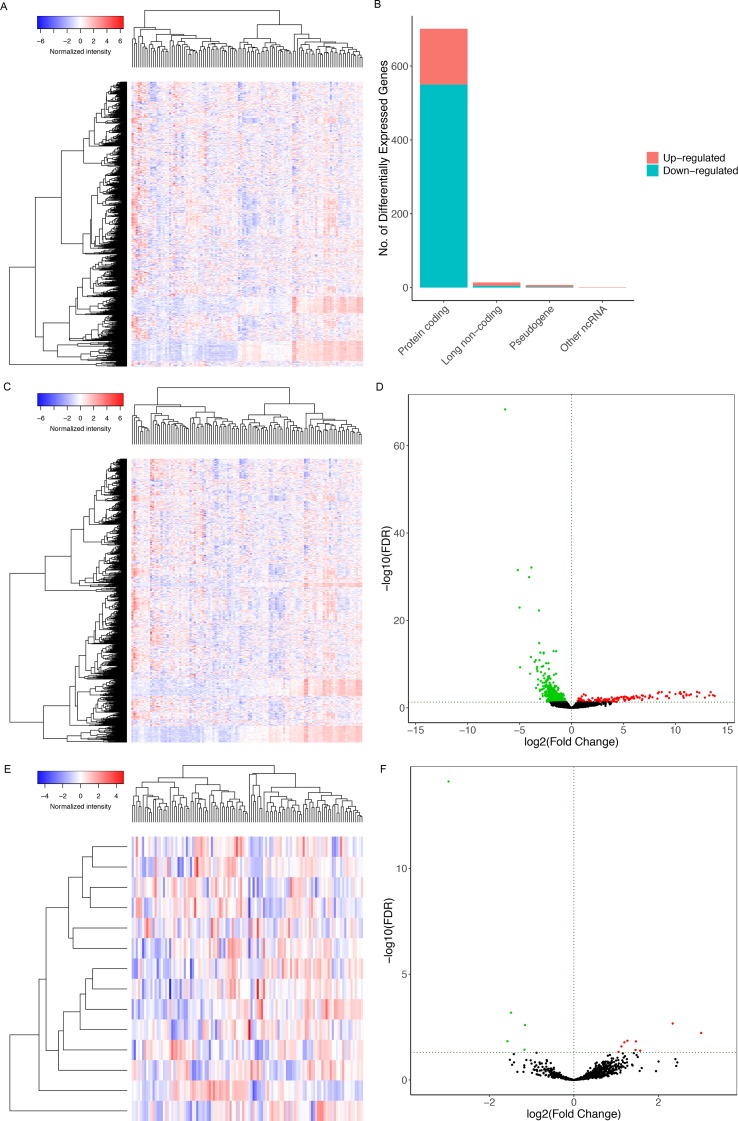
The heat maps of differentially expressed (A) RNAs, (C) miRNAs, (E) lncRNAs between the bone-metastatic melanoma and the primary melanoma. (B) Bar plot showing differentially expressed protein-coding genes, long noncoding genes, pseudogenes, and other RNAs. Red and blue represent up-regulated and down-regulated RNAs, respectively. It shows that 550 of 701 differentially expressed protein-coding genes are down-regulated and 151 are up-regulated. Besides, among 14 differentially expressed lncRNAs, 5 lncRNAs are down-regulated, and 9 are up-regulated. Volcano plots of differentially expressed mRNAs (D) and lncRNAs (F). We defined the log (fold change) >1.0 or <−1.0 and FDR <0.05 as the critical point. Thus, the red and blue dots in the plots represent high and low expression RNAs with statistical significance, respectively. Meanwhile, black dots represent mRNAs and lncRNAs without statistical significance between the primary and the bone-metastatic melanoma.